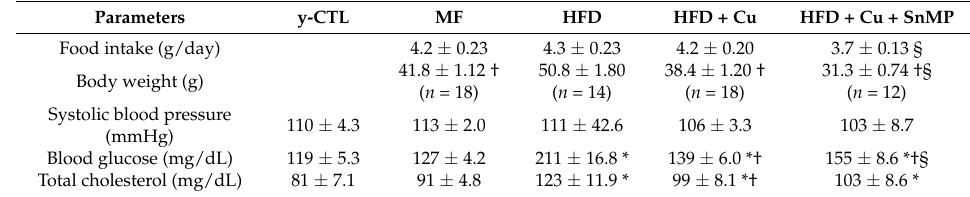
Table 1. Body weight, blood pressure, and blood glycolipid concentration of 80-week-old mice.